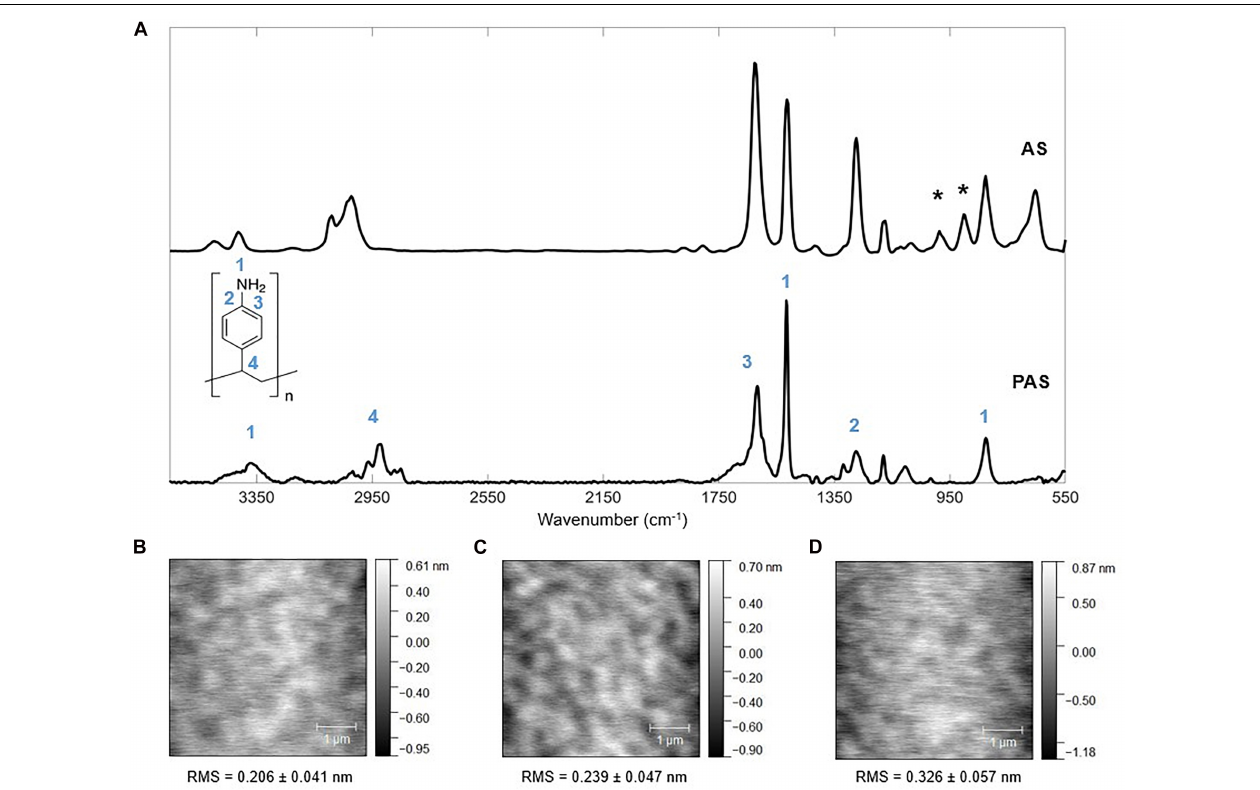
FIGURE 2 | Chemical and topographical characterization of PAS. (A) Fourier-transform infrared spectroscopy (FTIR) of AS standard (National Institute of Standards and Technology) and PAS thin film deposited via iCVD. Asterisks (*) in the AS spectrum correspond to vinyl bonds. The thickness of the FTIR sample is 133.67 ± 4.36 nm deposited using P m /P sat of 0.324. Atomic force microscopy (AFM) images of a 5 × 5 µ m view of iCVD PAS thin films deposited at P m /P sat of (B) 0.132, (C) 0.163, and (D) 0.235, with the root-mean-square (RMS) roughness labeled on each plot. Data = Mean ± SD, n = 2. The scale bar represents 1 µ